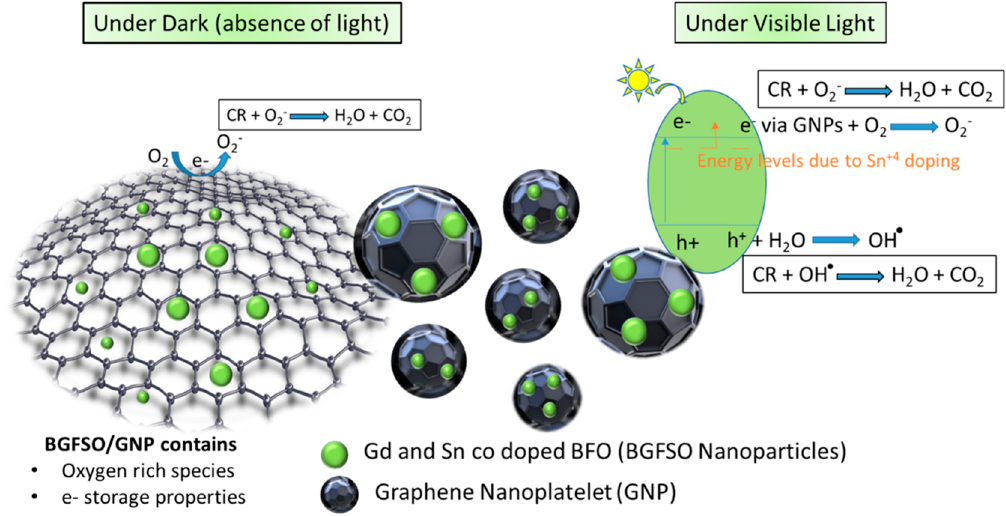
Figure 9. The catalytic mechanism inside BGFSO / GNP nanohybrids under both dark and visible light.